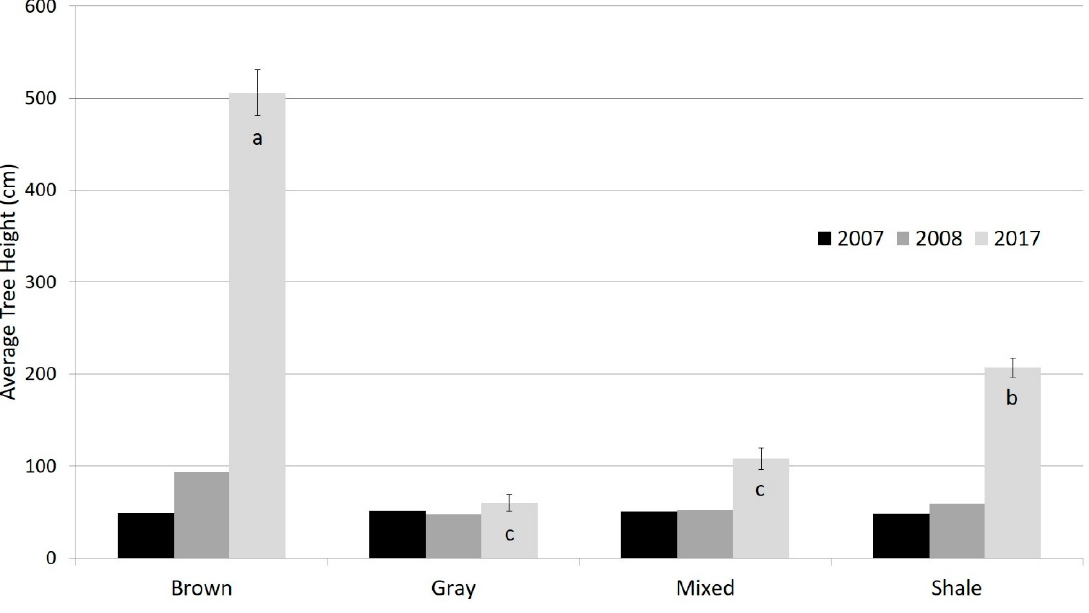
Figure 3. Average tree height (cm) across time (2007, 2008, 2017) and spoil type (brown sandstone, gray sandstone, mixed spoils, and shale). Error bars represent ± SE. Means with different letters are significantly different ( p < 0.05). Data from 2007–2008 from Miller et al. [12]. Table 2. Mean tree height (cm), with SE, by species and spoil type. Means with different letters are significantly different ( p < 0.05) across species within spoil type. Bold p -values indicate significant ANOVA ( p <